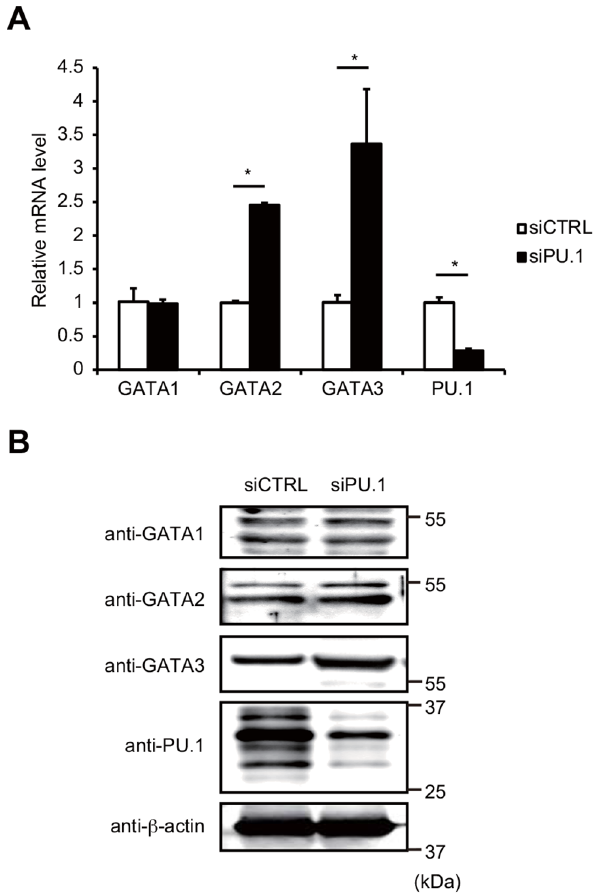
Fig 2. Effects of PU.1 knockdown on expression of GATAs, 1, 2, and 3. (A) BMDCs were transfected with either control (siCTRL; open bars) or PU.1 (siPU.1; closed bars) siRNA. After 48 h incubation, relative mRNA levels were determined by quantitative RT-PCR after normalization to GAPDH mRNA. Data are expressed as the ratio of the expression level of respective control siRNA-introduced cells. Results are means ± S.E.s ( n = 3). Similar results were obtained in three separate experiments. * , p < 0.05 in two-tailed paired Student ’ s t test. (B) Aliquots of total proteins (15 μ g/lane) of the indicated cells were subjected to SDS-PAGE and immunoblot analysis using the indicated antibodies. Similar results were obtained in three separate